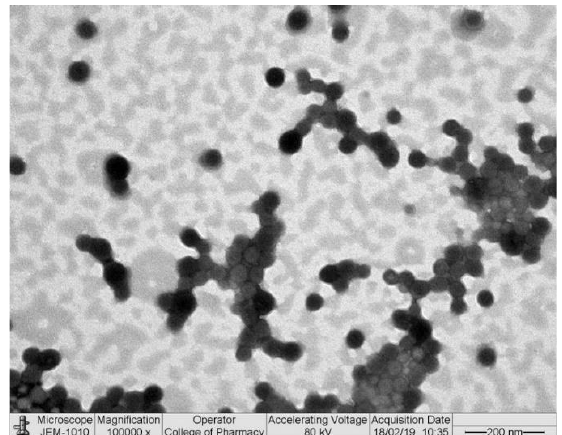
Figure 2. The morphological observation of LZ – CSNPs by Transmission Electron Microscopy. The imaging of the NPs was carried out at 100,000 – times magnification and the scale bar size was 200 nm.